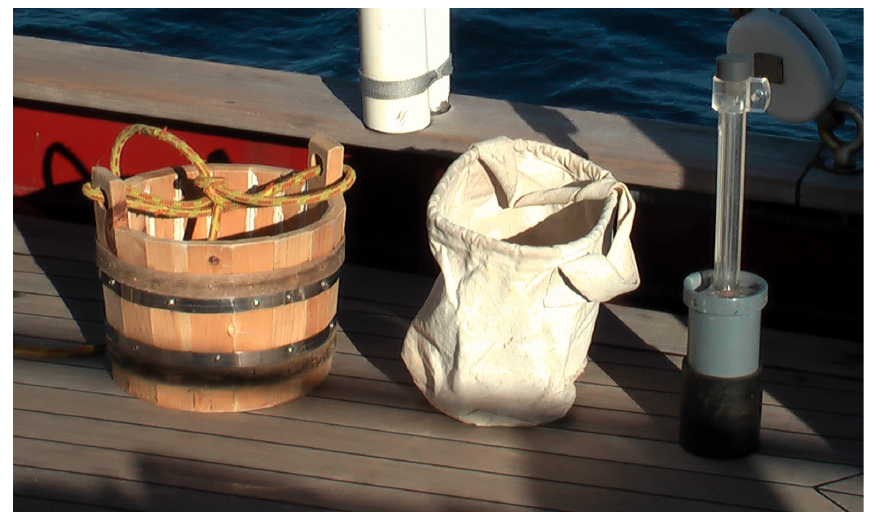
Fig. 2. From left to right, the wood, canvas and rubber buckets used in our field comparison. Note that the wooden bucket was sealed with white caulk along the inner seams and reinforced around the outside by two stainless steel bands. The rubber bucket is of both plastic and rubber construction, with a black rubber protective layer around the